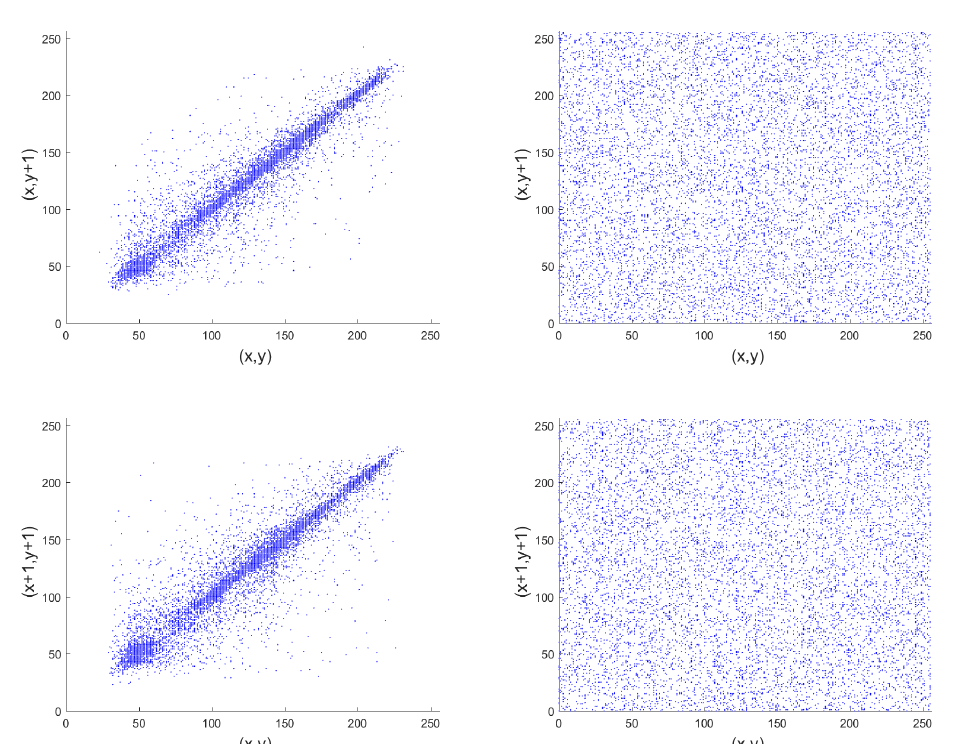
Figure 12. Distributions of the pixels in the Lena